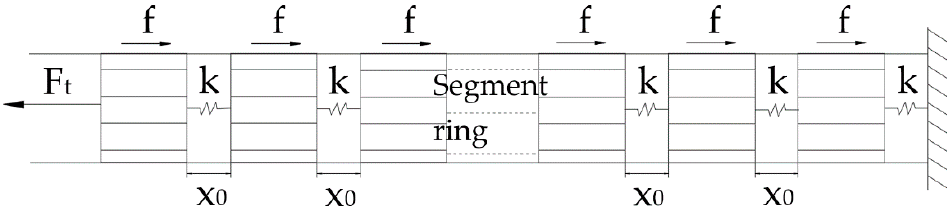
Figure 3. Simplified schematic diagram of load model of segment lining under thrust unloading.